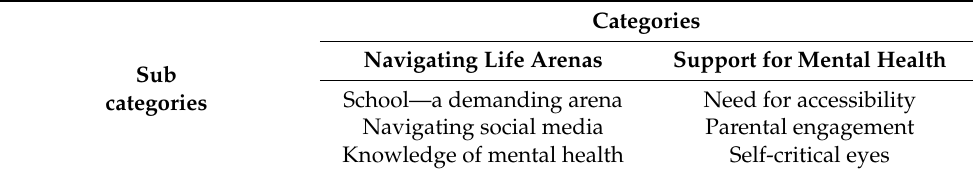
Table 1. Showing the results of categories and